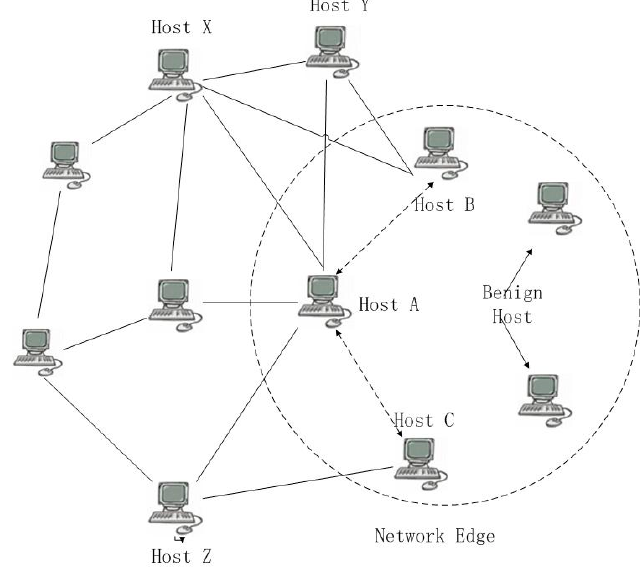
Figure 1. Network connection analytical model